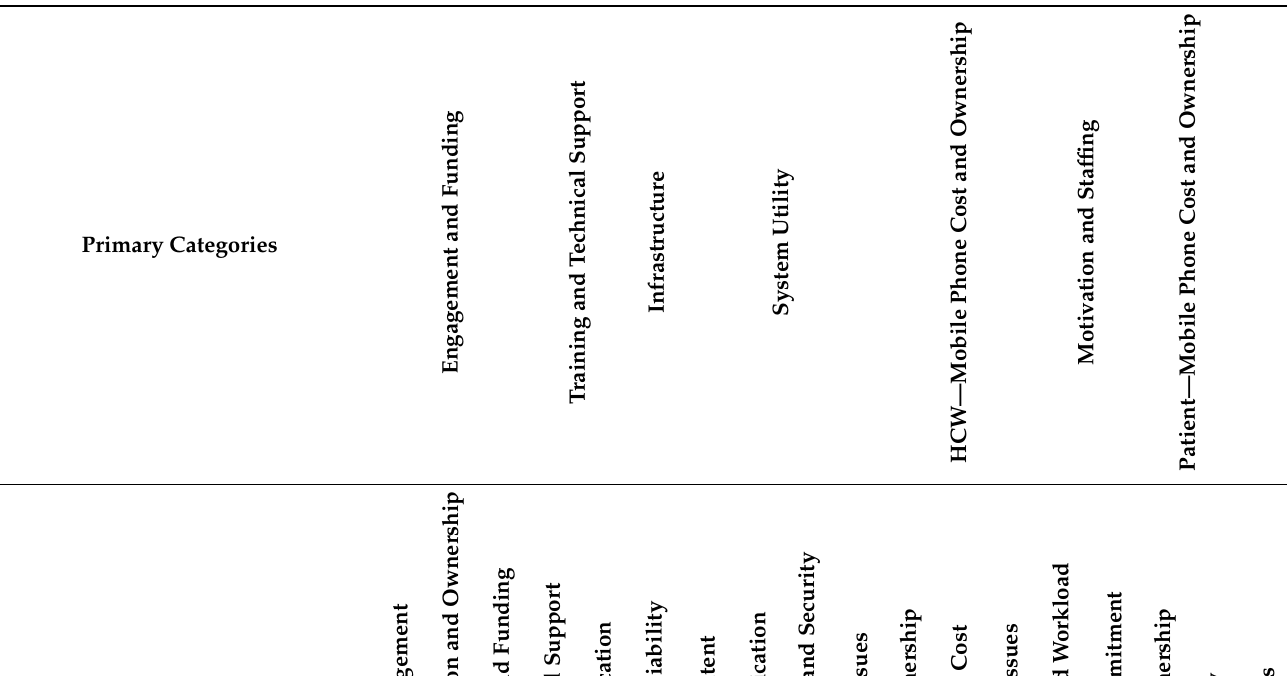
Table 2. Findings from 85 included publications. Check-mark indicates content relevant to one of seven Primary Categories or 17 sub-categories (miscellaneous sub-category discussed in the Results). HCW = Healthcare